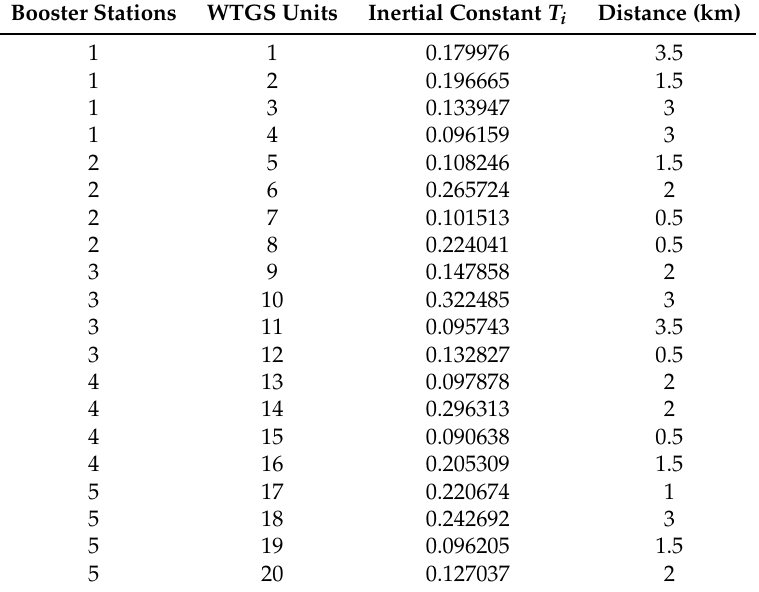
Table 1. Units characteristics (WTGS: wind turbine generator